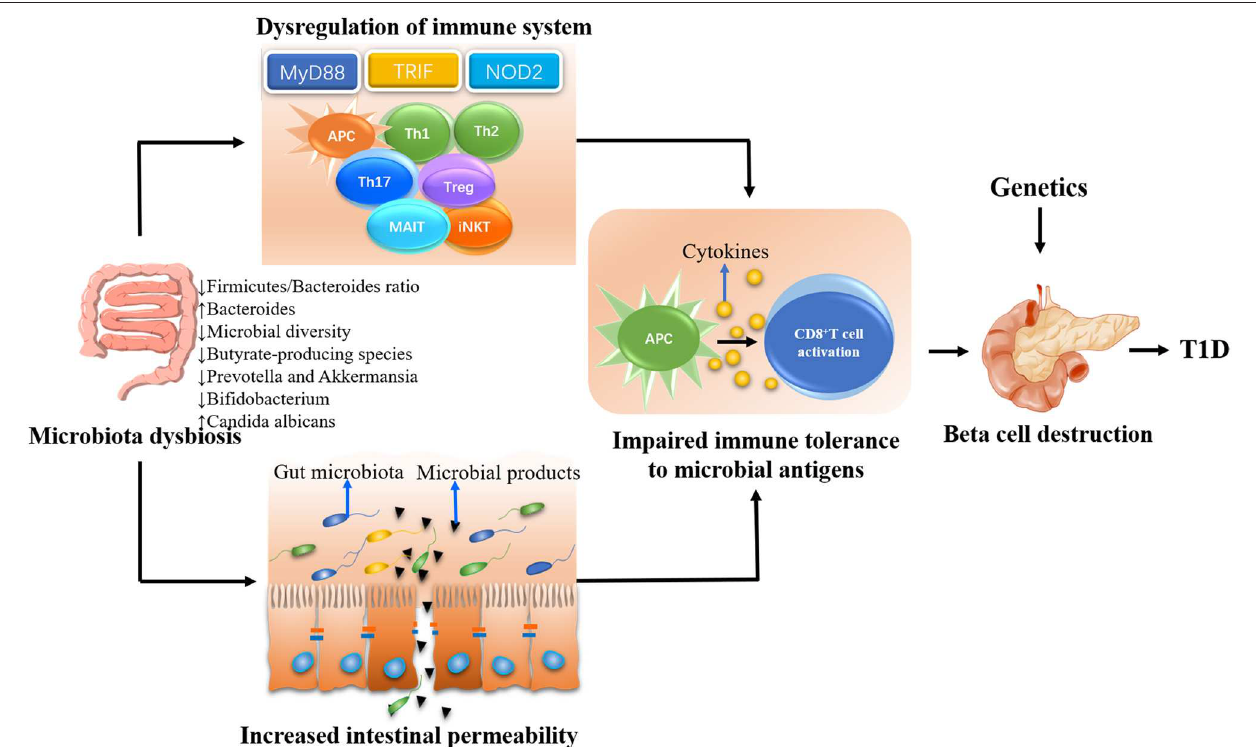
FIGURE 1 | The possible mechanisms whereby gut microbiota influences the type 1 diabetes (T1D) development. The gut microbiota plays a decisive role in the maturation of immune system in early life. Gut dysbiosis will lead to the dysregulation of immune response including both innate and adaptive immune system, eventually resulting in beta cell destruction and the onset of T1D in genetically susceptible individuals. On the other hand, the gut dysbiosis can lead to the disassembly of tight junctions, thereby disrupting the integrity of intestinal barrier. The enhanced intestinal permeability will allow unregulated passage of microbial antigens such as microbiota and their products. These antigens escaping from intestinal tract could be untaken by antigen-presenting cells (APCs), which can process and present antigens to autoreactive T cells and subsequently promote the destruction of pancreatic beta cells in genetically predisposed individuals.